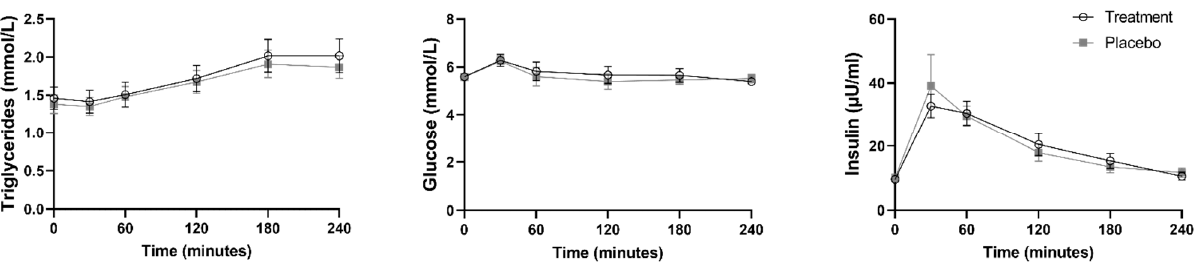
Figure 3. Plasma metabolic markers before and after consumption of study yoghurts. Data represented as mean and SEM.